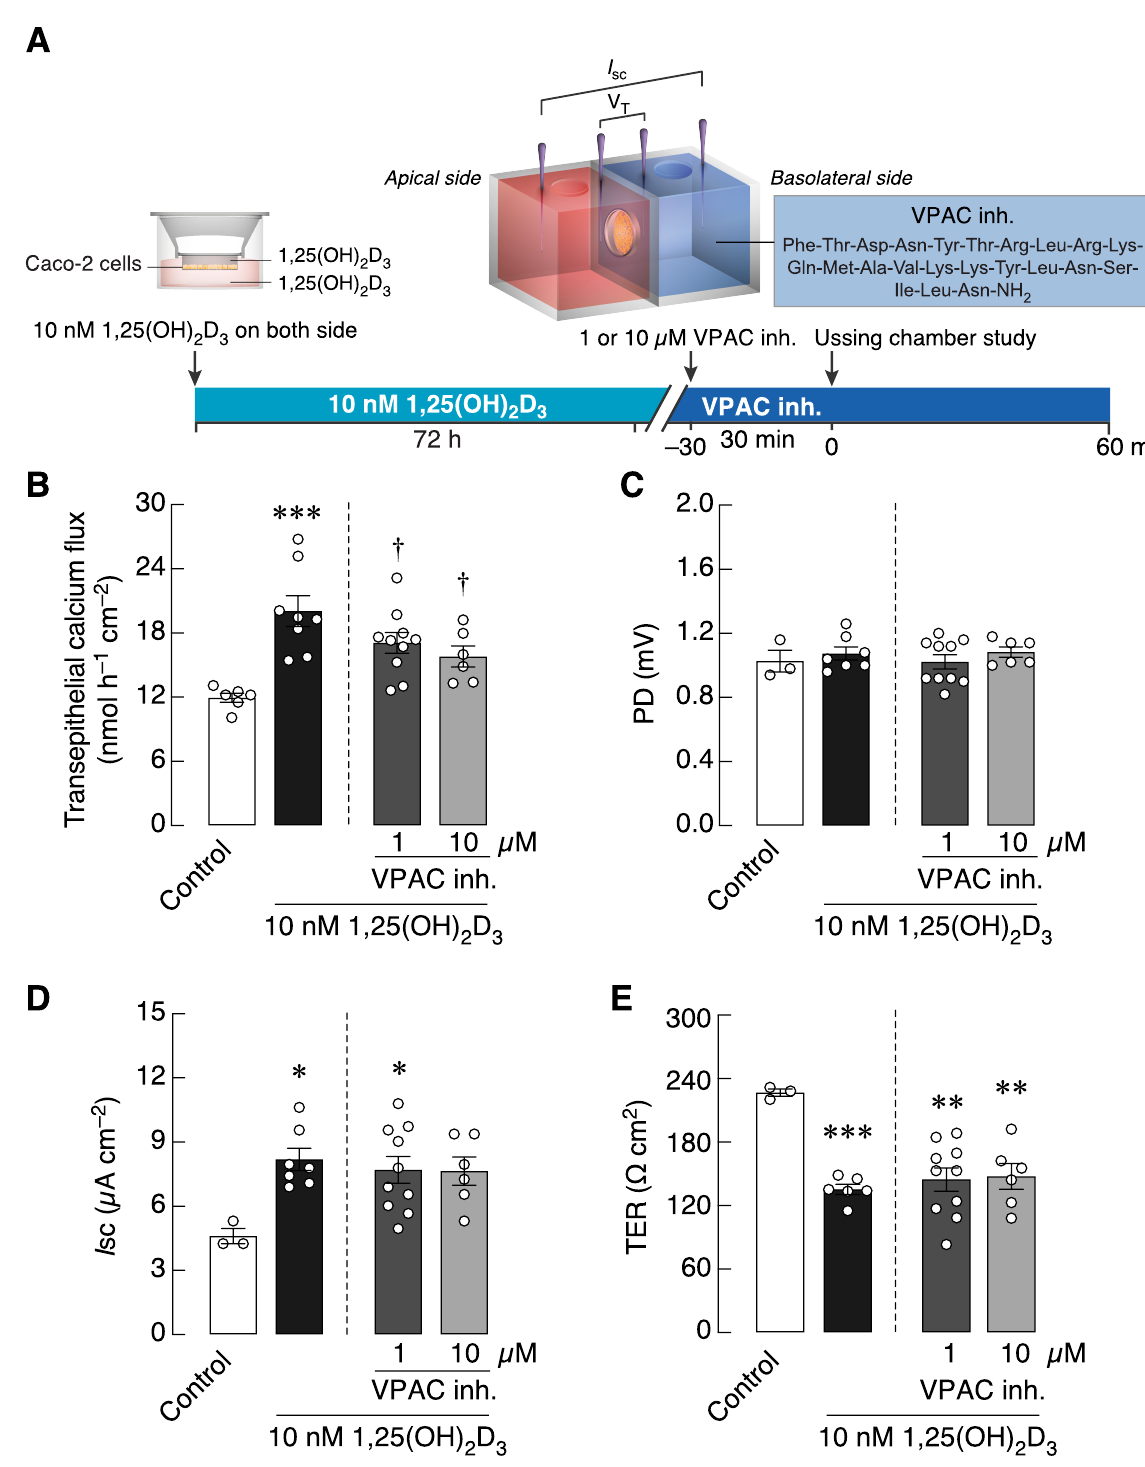
Fig 3. The effects of VIP/pituitary adenylate cyclase-activating polypeptide receptor (VPAC) inhibitor on intestinal epithelium-like Caco- 2 monolayers. (A) Timeline of Experiment 2. (B) Transepithelial calcium flux and (C–E) epithelial electrical parameters (PD, I sc , and TER) across Caco-2 monolayers pretreated with 10 nM 1,25(OH) 2 D 3 for 72 h and then exposed to 1 and 10 μ M VPAC inh. on the basolateral side for 30 min. � p < 0.05; �� p < 0.01; ��� p < 0.001 vs. control group (open bar, one-way ANOVA with Tukey’s multiple comparison test). † p < 0.05 vs. 10 nM 1,25(OH) 2 D 3 -treated group (closed bar, one-way ANOVA with Tukey’s multiple comparison test).